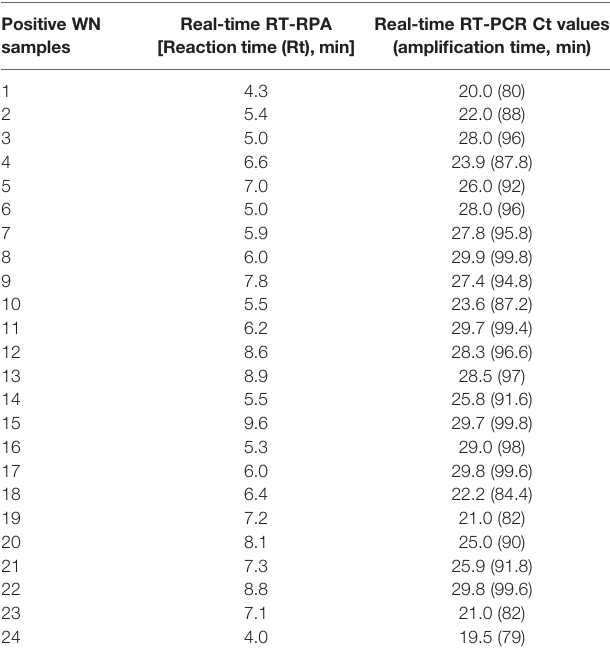
TABLE 4 | Detection of West Nile virus (WNV) by reverse transcription recombinase polymerase ampli fi cation (RT-RPA) and real-time RT-PCR in clinical samples. Positive WN samples